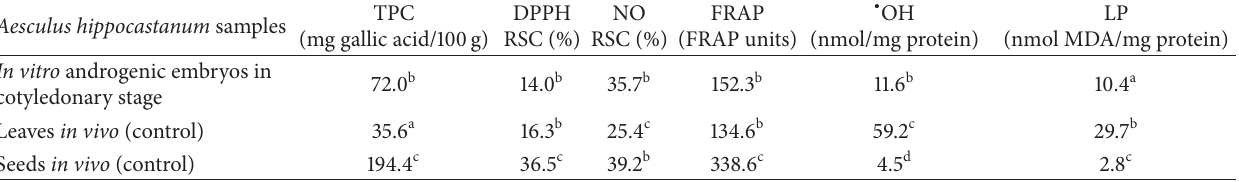
Table 4: Soluble protein content, antioxidant enzyme activities (SOD, GPx and CAT), and glutathione, and total thiol content in A. hippocastanum . Proteins Aesculus hippocastanum organs (mg/g)